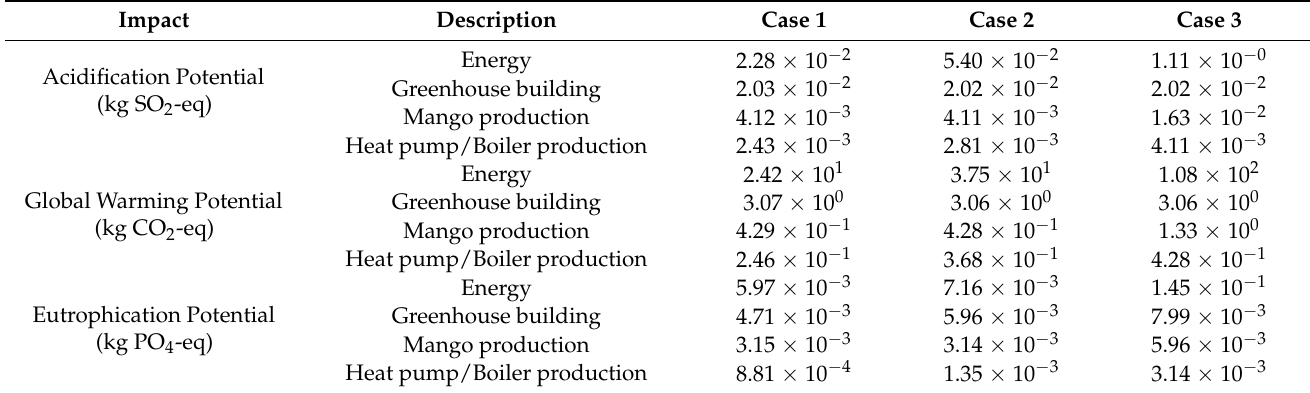
Table 3. Detailed impact environmental assessment results in the three scenario cases.